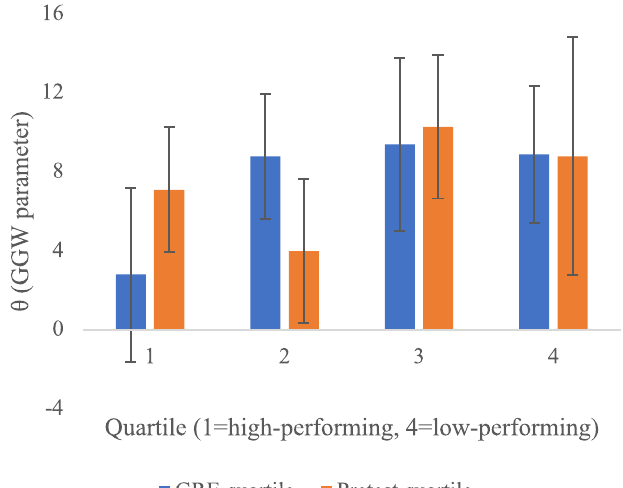
FIG. 3. θ resulting from the mixed linear model (1) for quartiles of the 133 total students. Here, the 4th GRE Physics quartile is the 25% of students with the lowest GRE Physics scores, and so on. The error bars indicate standard